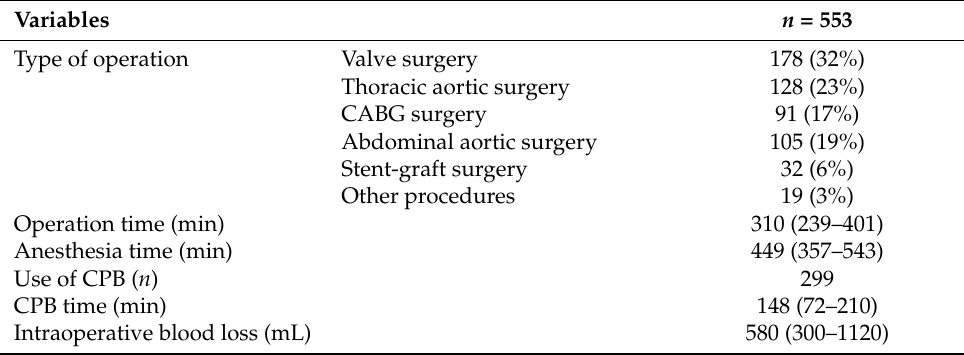
Table 3. Type of operation and other operative